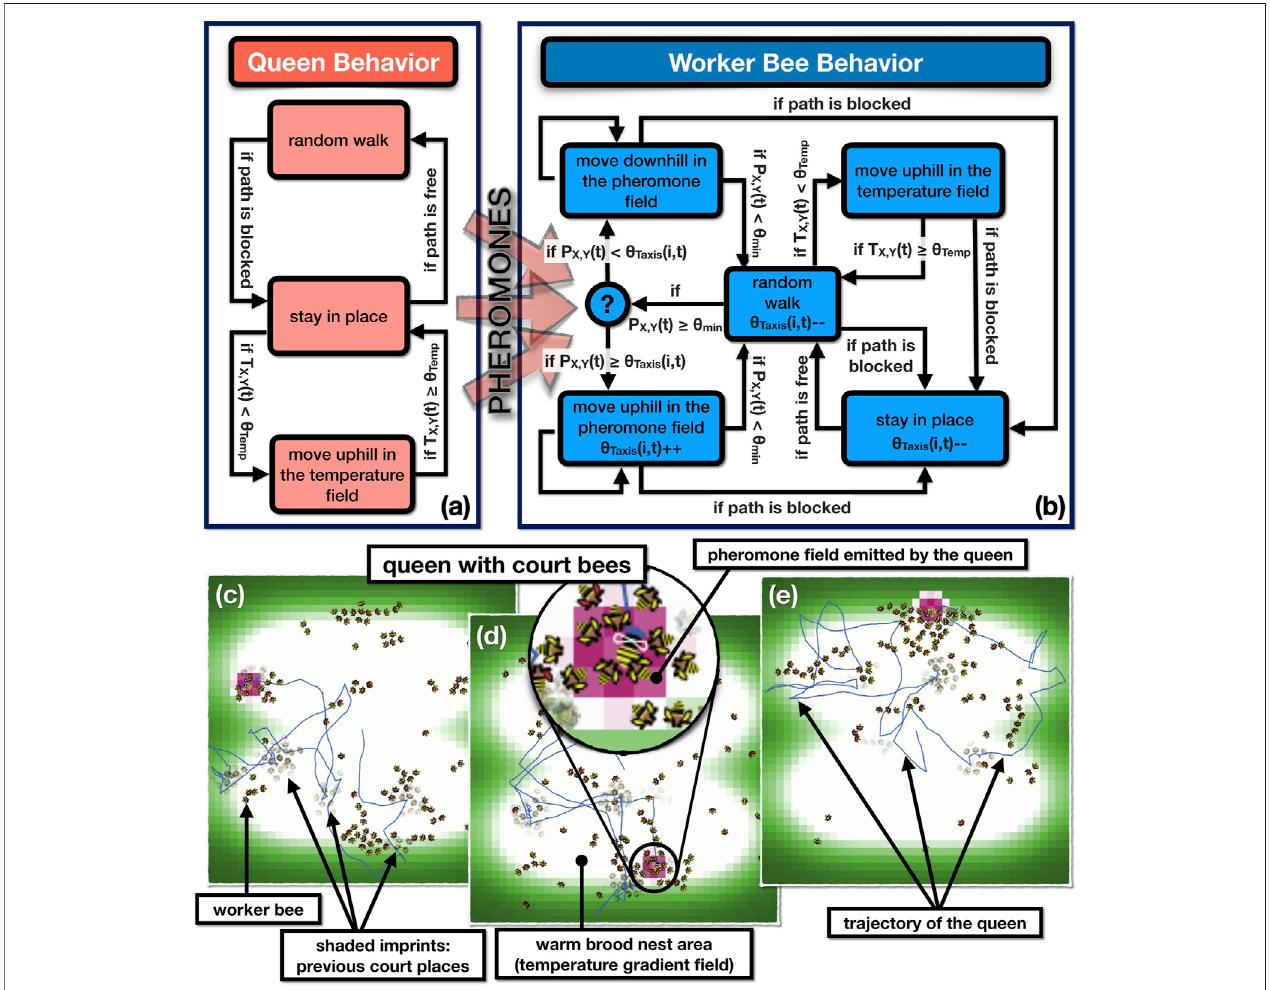
FIGURE11| Agent-basedmodelofthequeenandtheworkerbees.Uppersub fi gures (A,B) :Basiccomputationalstructuresintheagent-based modelexpressed as two interacting fi nite state machines. Colored boxes indicate behavioral states of agents, the arrows between the boxes indicate transitions between these states. At each arrow, the condition or the probability of the transition is given. Lower sub fi gures (C-E) : Screenshots depicting the basic emerging structures in the system: the pheromone fi eld, the courts, the trajectories of the agents and the patio-temporal self-organization within the system.